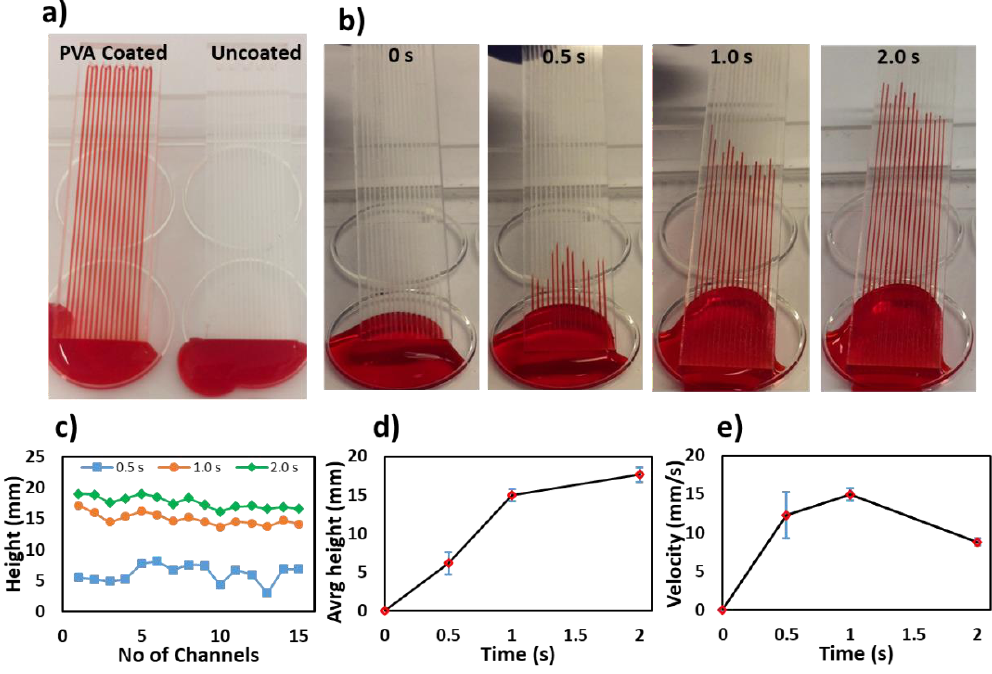
Figure 2. Characterization of the polyvinyl alcohol (PVA) coating and fluid rise in the microchannels. ( a ) Photograph of the uncoated and PVA-coated microchannels. PVA coating renders the polymethyl methacrylate (PMMA) surface hydrophilic and allows a liquid to rise in the microchannels. ( b ) Time-lapse photos of a red food dye rising in PVA-coated microchannels at different times (0, 0.5, 1.0 and 2.0 s). ( c ) Height of the 15 microchannels in a single chip at multiple times (0.5, 1.0 and 2.0 s). ( d ) Graph of time versus average fluid height in the 15 microchannels, showing an increase in height with time. ( e ) Graph of time versus filling velocity in the 15 microchannels.